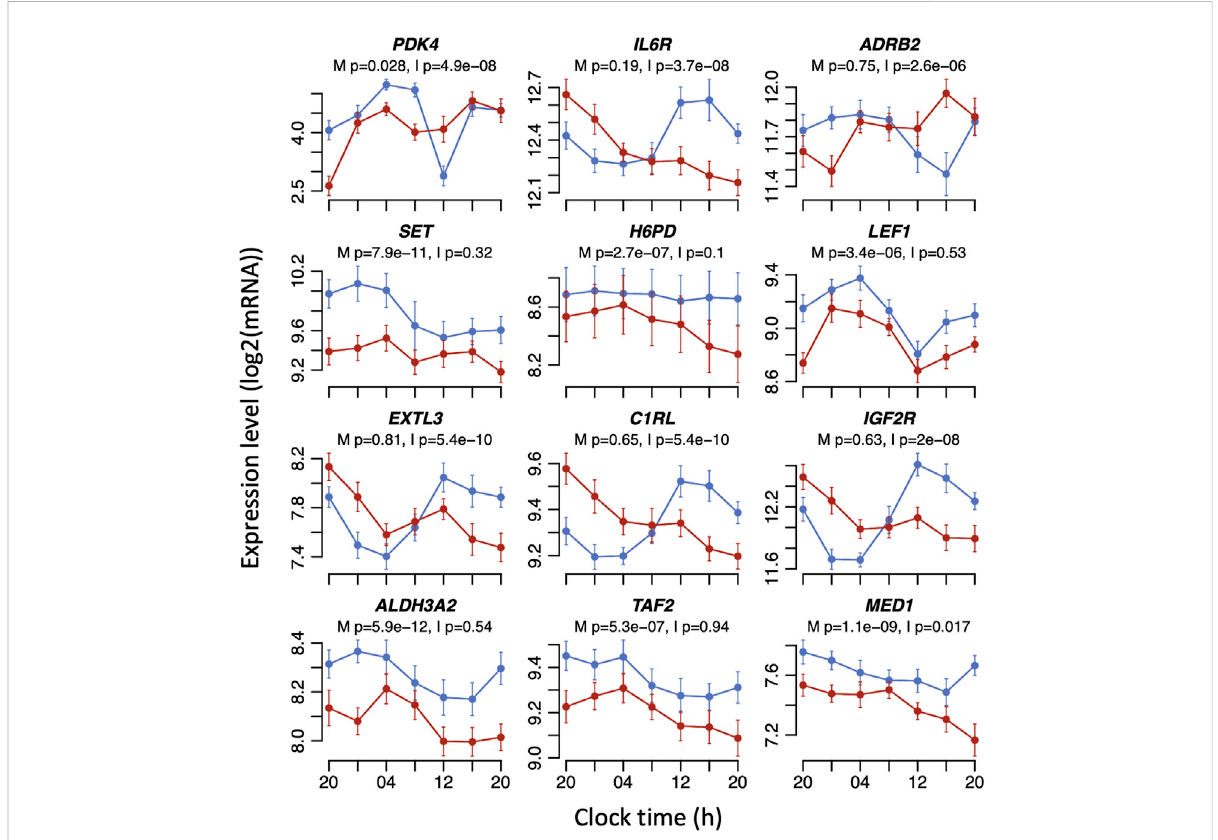
FIGURE 4 Example expression plots for mouse adipocyte (top six) and human whole blood (bottom six) dexamethasone-induced transcripts that are signi fi cantly affected by sleeping out-of-phase in the mistimed sleep dataset. Mean RNA expression (log 2 ± SE) pro fi les are plotted for sleeping in- phase(blue)andsleepingout-of-phase(red).MixedmodelANOVABH-corrected p valuesareindicatedforamaineffectofsleepcondition(M)orthe interaction sleep condition x sample time (I). Please note that the main effects of sleep conditions or the interaction only imply that the mean expressionlevelsand/ortemporalpro fi lesoftranscriptshavechanged.ThemixedmodelANOVAdoesnotrelyontheassessmentofthesigni fi cance of circadian rhythmicity or rhythm parameters such as amplitude or